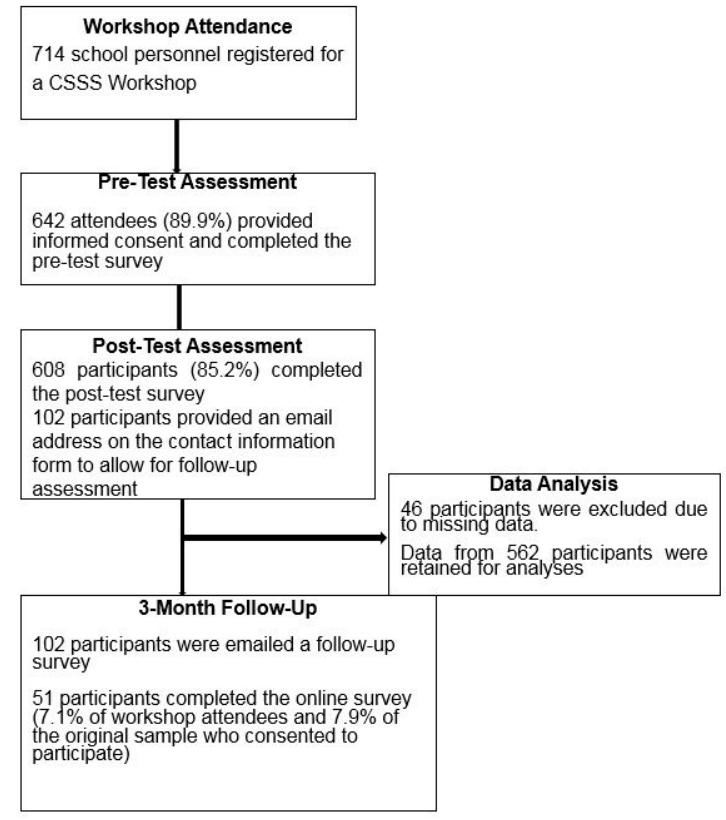
Figure 1. Flowchart of workshop attendees who participated in the investigation.